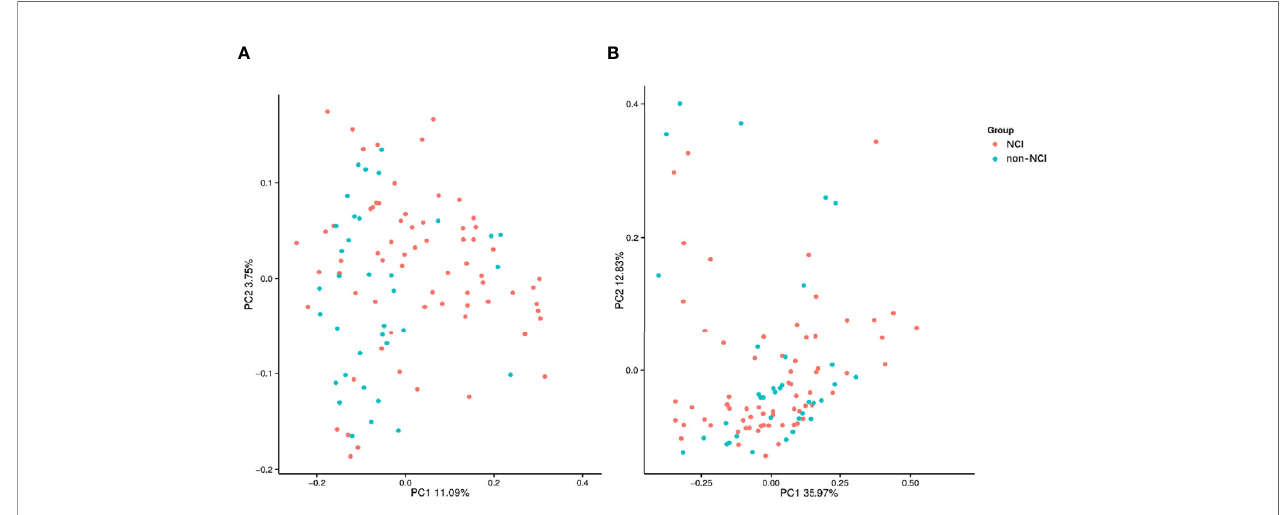
FIGURE 2 | Unweighted (A) and weighted (B) analyses of similarities and principal coordinate analysis based on the distance matrix of UniFrac dissimilarity of the fecal microbial communities in the NCI and non-NCI groups. NCI group, HIV-infected persons with neurocognitive impairment; non-NCI, HIV-infected persons without neurocognitive impairment; PC, principal components. Each symbol represents a